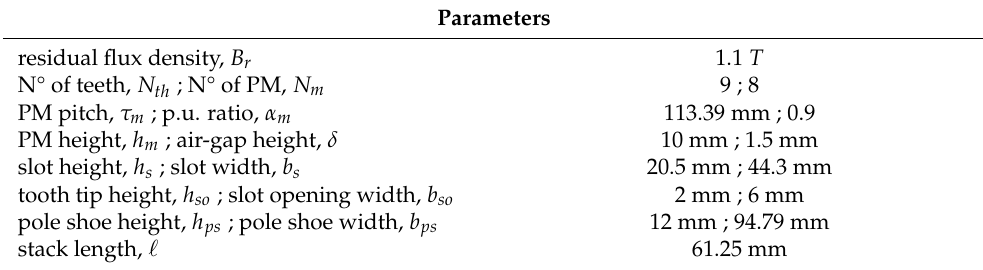
Figure 5. ( a ) Machine case of study: (1) slotless: zones A (cid:13) and B (cid:13) both filled with iron; (2) slotted: zone A (cid:13) filled with iron and B (cid:13) with air. ( b ) Zoom with main sizes. Table 1. Machine Main